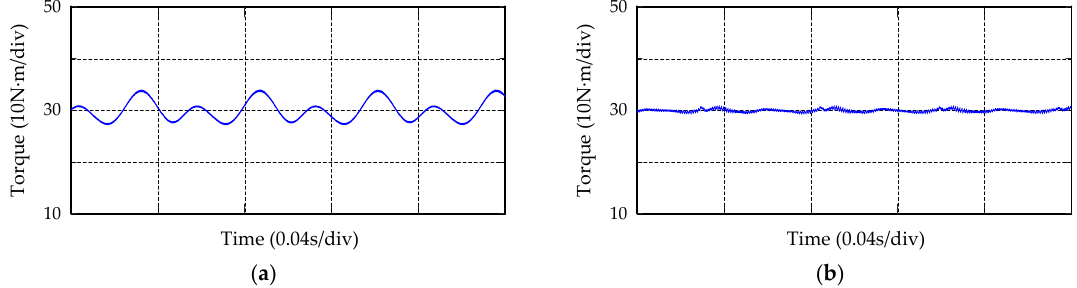
Figure 17. Torque waveform when the speed of five-phase PMSM is 50 r/min: ( a ) Torque waveform of removing faulty phase after a short-circuit; ( b ) Torque waveform after adding RC.